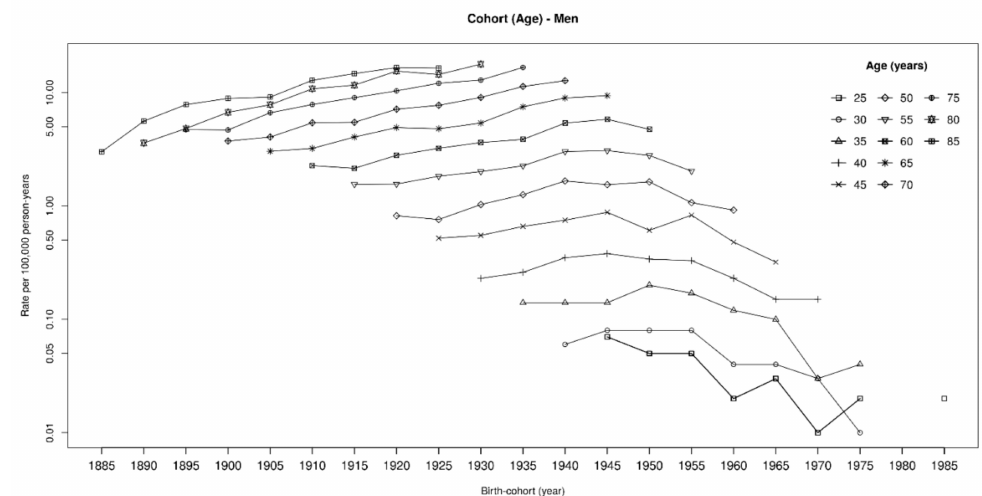
Figure 1. Malignant pleural mesothelioma death rates ( × 100,000) by age and birth cohort. Men, Italy, 1970–2014.